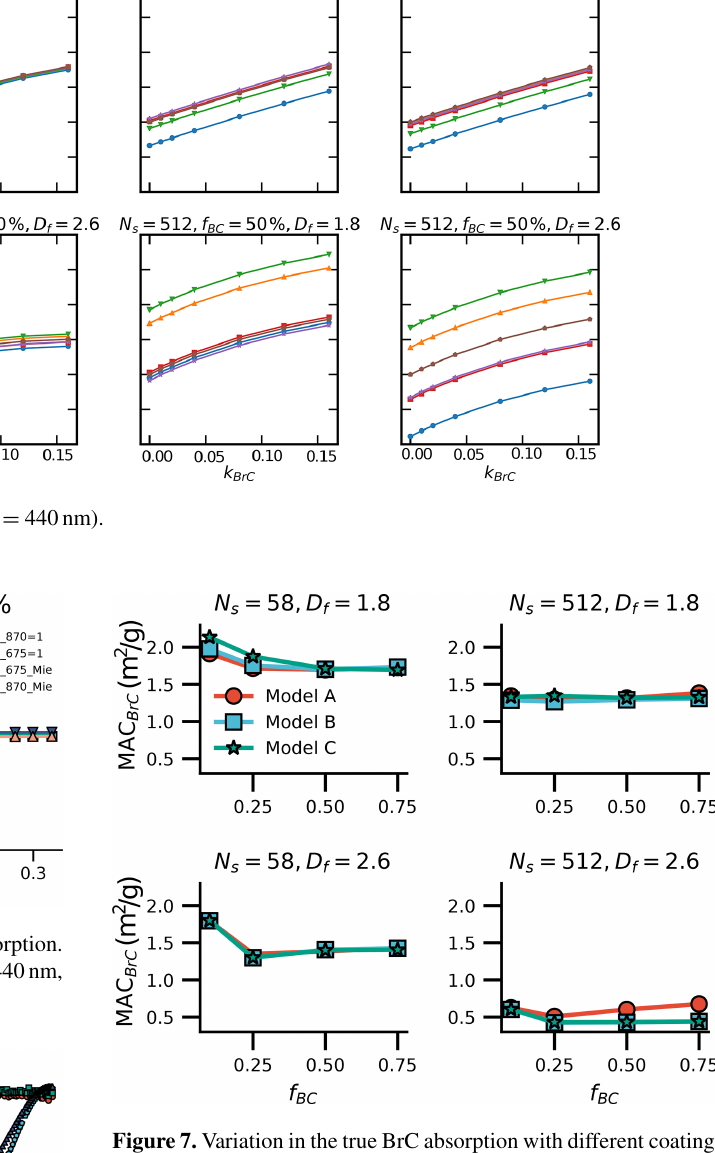
Figure 7. Variation in the true BrC absorption with different coating models ( k BrC =0.08, λ =